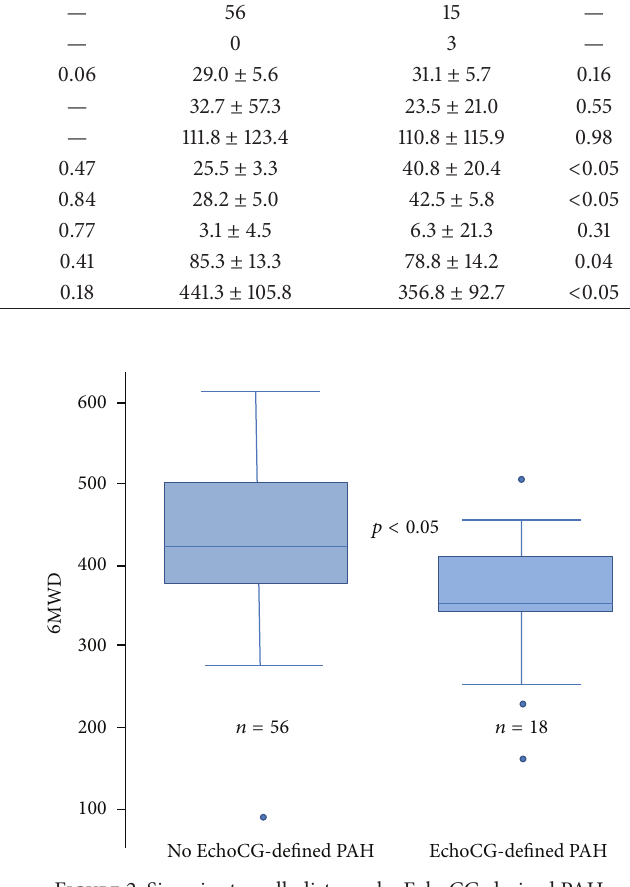
Figure 2: Six-minute walk distance by EchoCG-derived PAH.